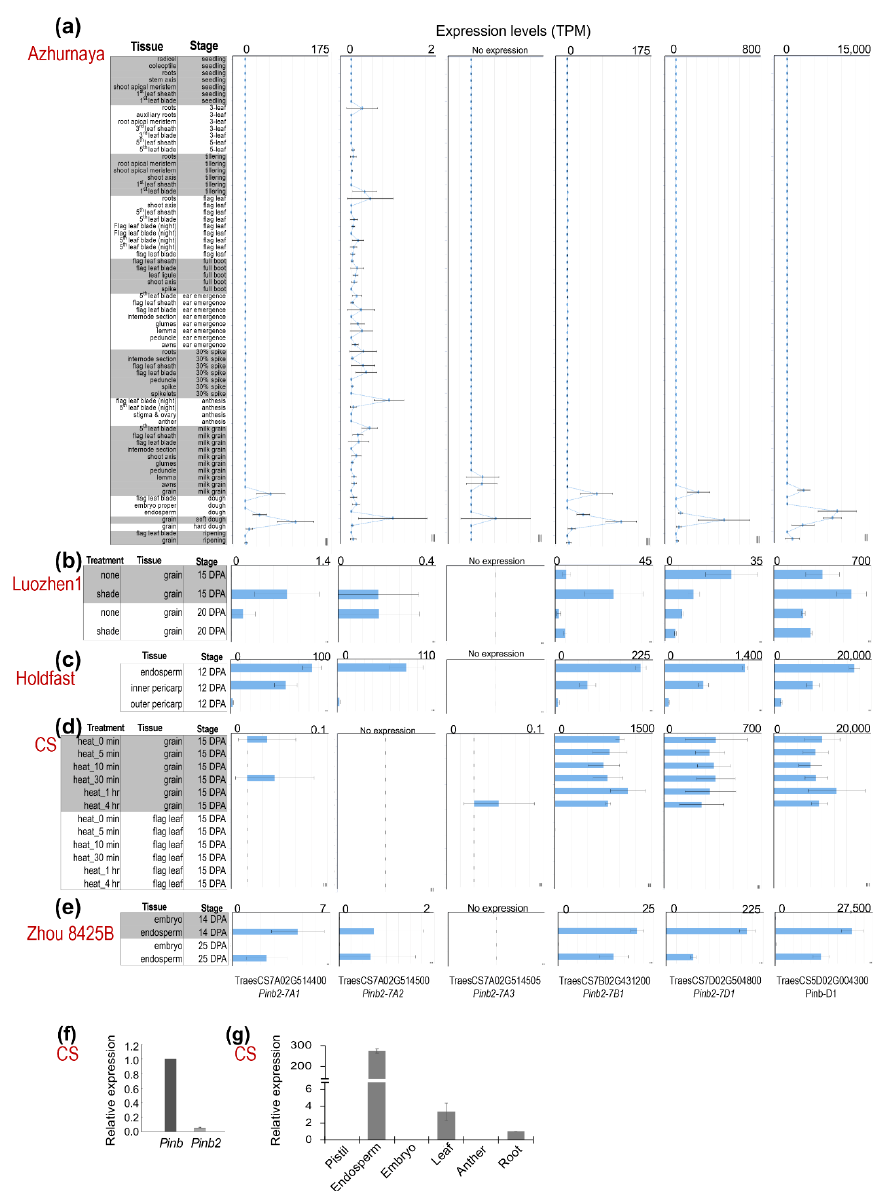
Figure 3. Expression patterns of Pinb2 genes. Expression levels of Pinb2 genes and Pinb-D1 from five publicly available RNA-seq datasets and shown in bar charts ( a – e ). The varieties used for RNA-seq analyses are indicated in red, while the tissues, developmental stages and conditions for each RNA-seq experiments are labeled on the left of each panel. Expression levels are shown using TPM and are not normalized across datasets. ( f ) The relative expression levels of Pinb and Pinb2 genes were quantified using qRT-PCR at 28 Days Post Anthesis (DPA) in CS seeds. ( g ) Expression levels of Pinb2 genes in di ff erent tissues from CS proved Pinb2 genes are expressed specific in seeds. Detailed information of the RNA-seq datasets used are given in Table